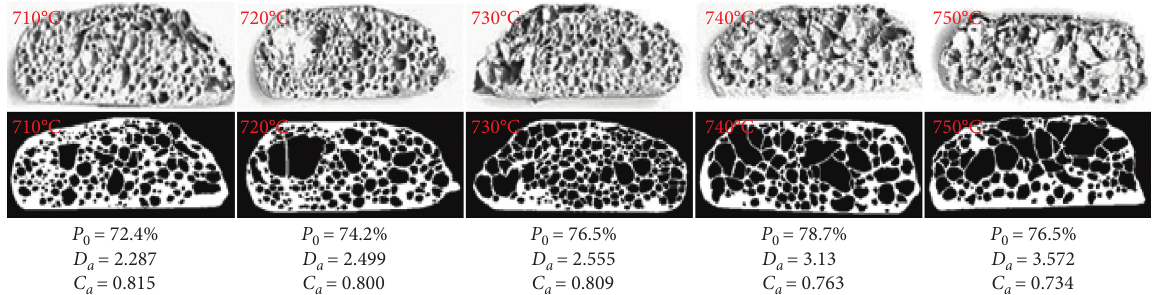
Figure 7: Cross-sectional macrographs of foams in tube A on the five sample temperatures at furnace temperature 800 ° C.